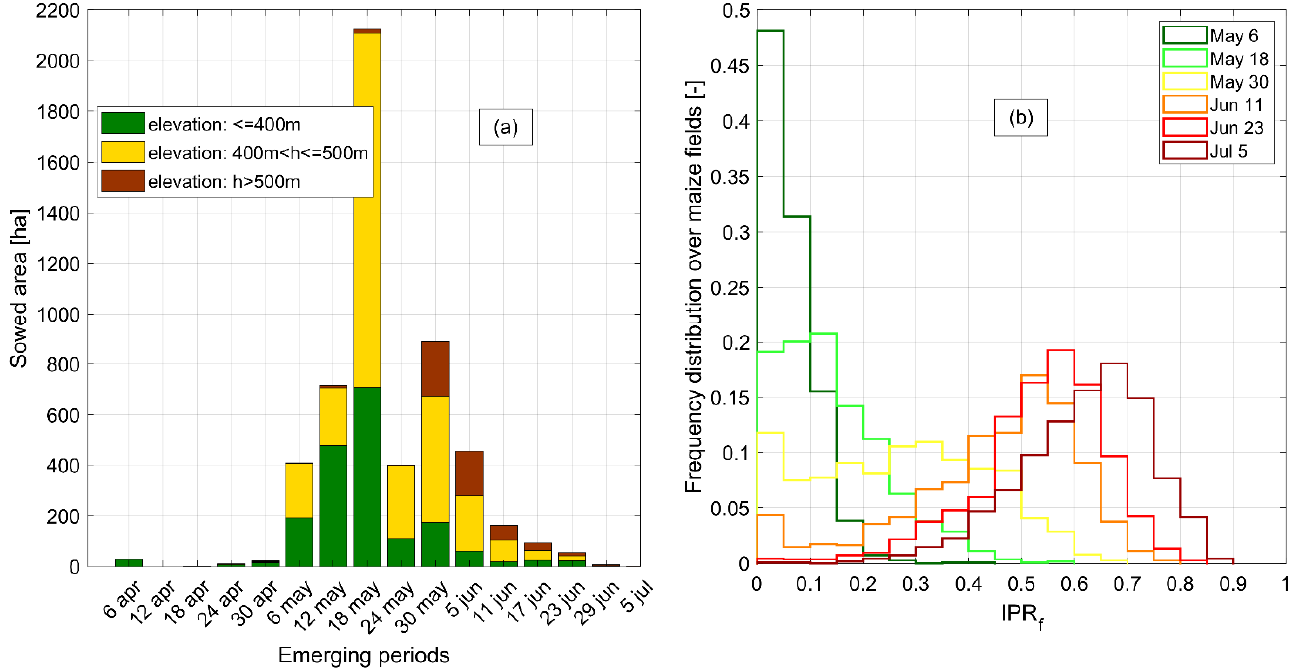
Figure 6. ( a ) Temporal distribution of emergence periods (i.e., the periods when the plants emerge through the soil). The 6 – days revised time refers to the availability of radar data that were used for the analysis. For each day, the hectares where the plants have come out from the ground have been cumulated according to the class of elevation (meters above the sea level). ( b ) Temporal variation of the IPR f frequency distribution. After the end of June, no more fields show values < 0.1, showing that the maize has passed the emergence phase.